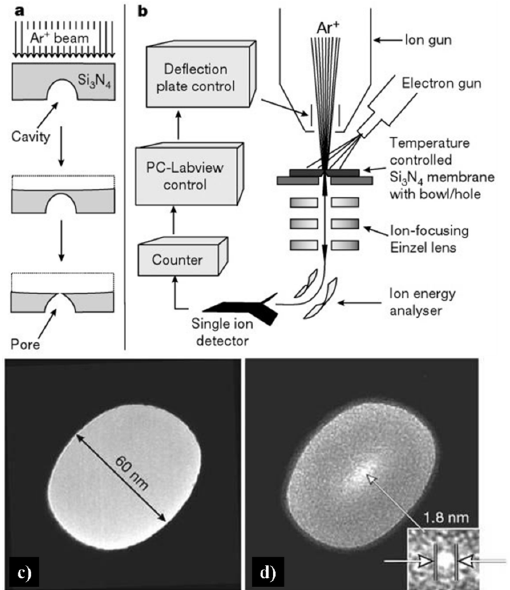
Figure 6. Strategy for making nanopores using argon ion-beam sputtering, and transmission electron microscopy (TEM) images of the nanopore in 500-nm Si 3 N 4